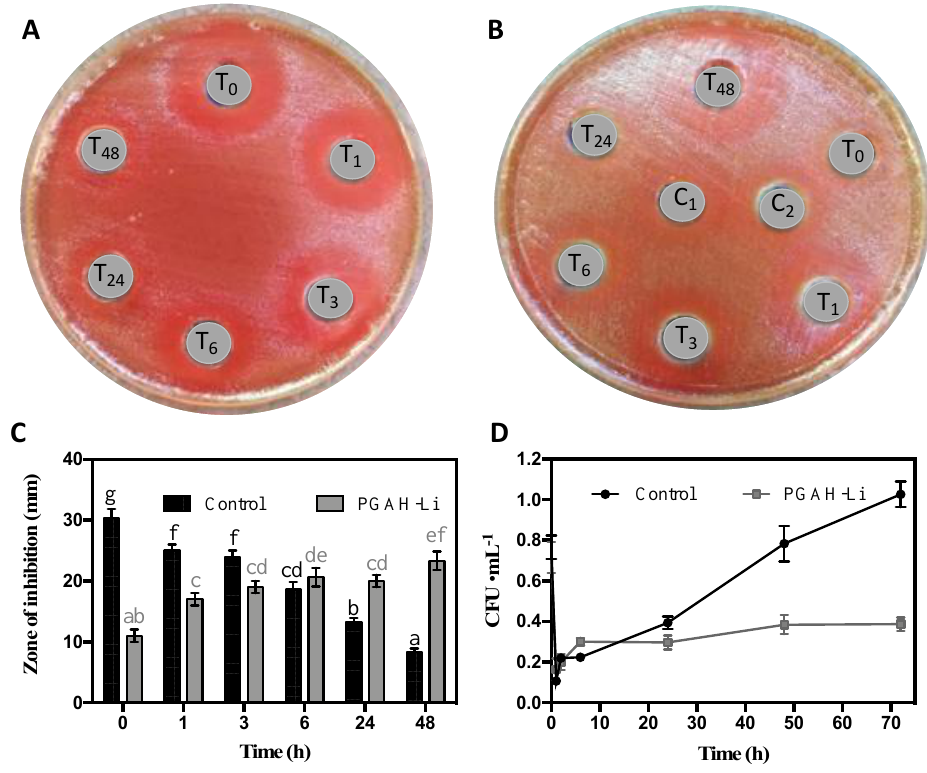
Figure 7. Screening of the antibacterial effect of PGAH-Li. Control ( A ); PGAH-Li ( B ); T 0 : 0 h, T 1 : 1 h, T 3 : 3 h, T 4 : 6 h, T 24 : 24 h, T 48 : 48 h; the antibacterial effect was expressed as the inhibition area against E. faecium ( C ); quantitative test of antibacterial activity against E. faecium ( D ). (Equal letters above the bars indicate that there are no statistically significant differences using Tukey ’ s HSD procedure, at 95% confidence level). C 1 and C 2 in Figure 7B are positive controls of 15 and 10 μg mL − 1 linezolid, respectively.